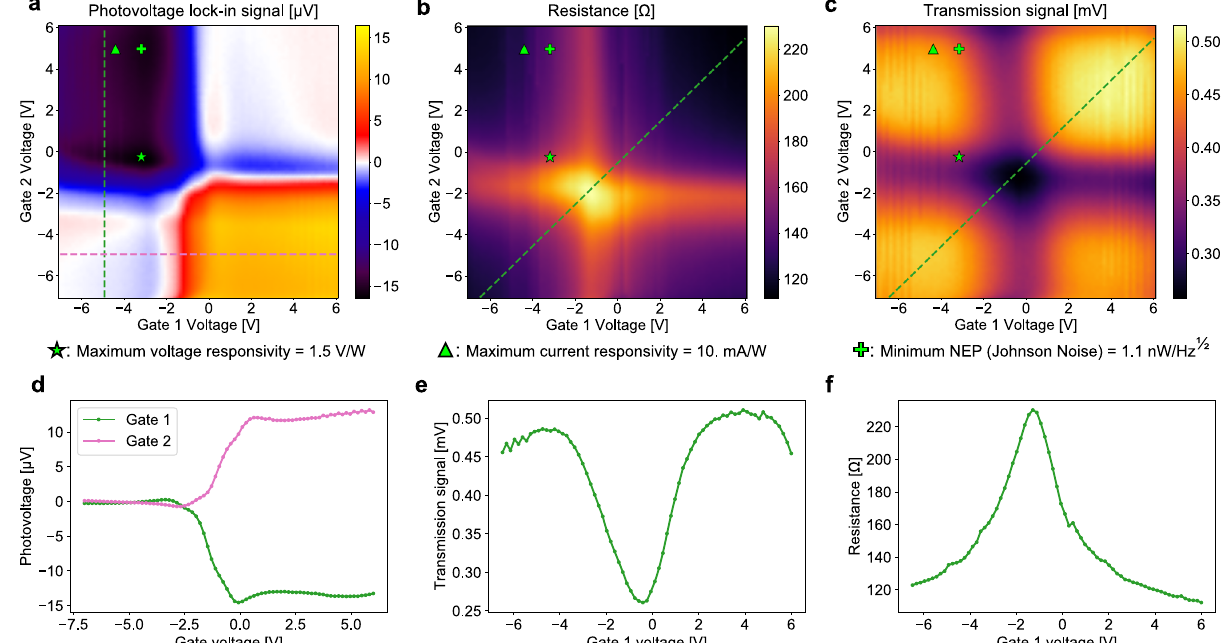
Fig. 2 Gate voltage maps. a Measured zero-bias photovoltage produced by the device as a function of the two gate voltages. b Total device resistance as a function of the two gate voltages. c Lock-in signal re fl ecting power measured by an InAsSb photodetector at the focal point of our output facet collection lens, used to monitor transmission of the device as a function of the gate voltages. The star, triangle, and cross symbols on each gate voltage map represent the optimum operating points for maximum voltage responsivity, maximum current responsivity, and minimum NEP, respectively. The power- normalized transmittance is plotted in Supplementary Fig. 3b. d , e , f Plots of line sections indicated with dashed lines in panels a , b , and c ,